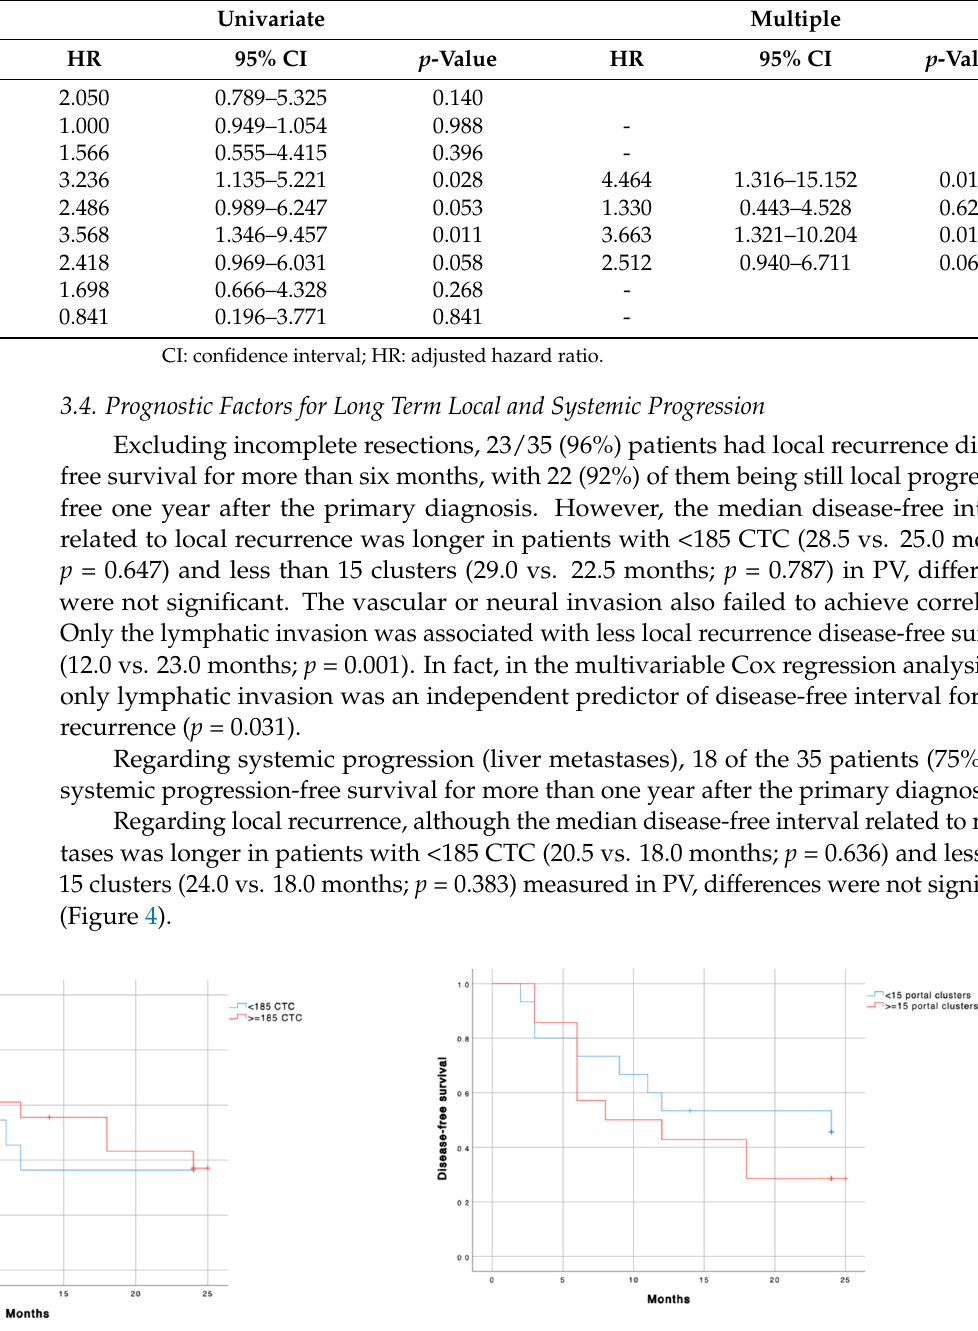
Table 9. Prognostic factors for long-term survival. Covariates were patient age, disease stage (I–II), portal CTC ≥ 185, portal clusters ≥ 15, microscopic invasion (vascular, lymphatic, neural), and tumor degree of differentiation (G1–3).